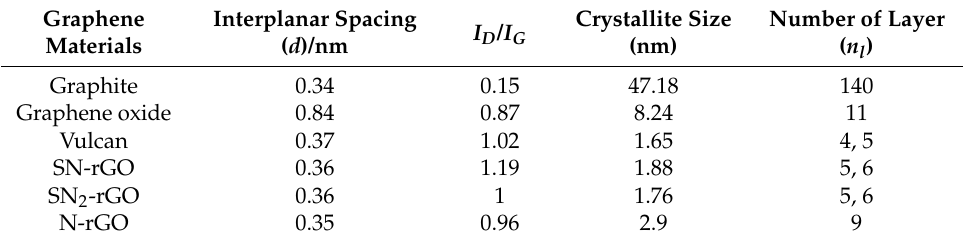
Table 1. X-ray diffraction (XRD) and Raman parameters for all studied